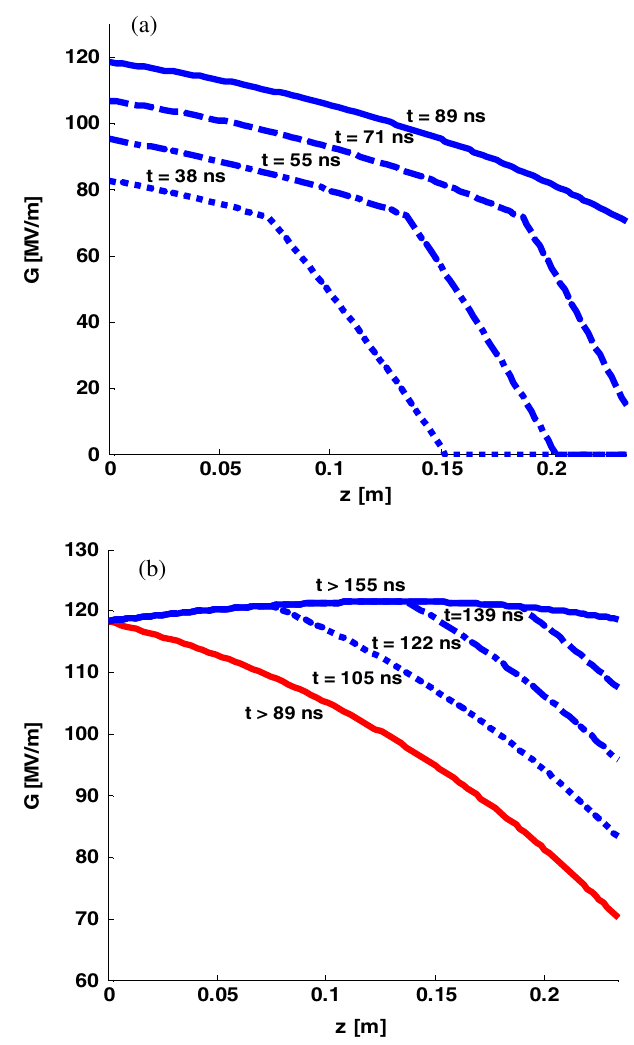
FIG. 7. The instantaneous unloaded gradient distribution along the structure at different moments of time is presented in (a). Special correction to the input rf pulse was applied (see Fig. 6). In (b), the instantaneous unloaded gradient at different moments of time after beam injection is shown in blue. Solid lines represent the steady state distributions for loaded (red) and unloaded (blue) gradients. The beam injection time is 89